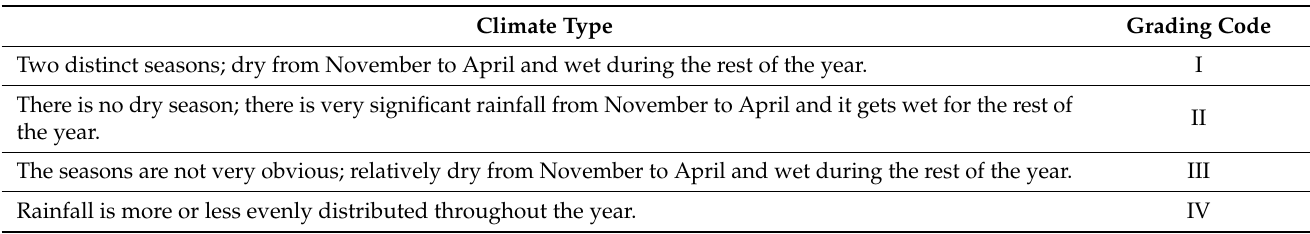
Table 4. Definition of climate index.